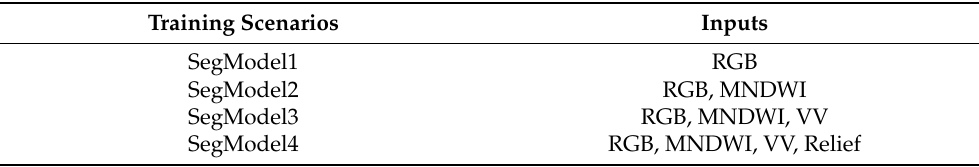
Table 4. Input data combinations for driving the segmentation models. Training